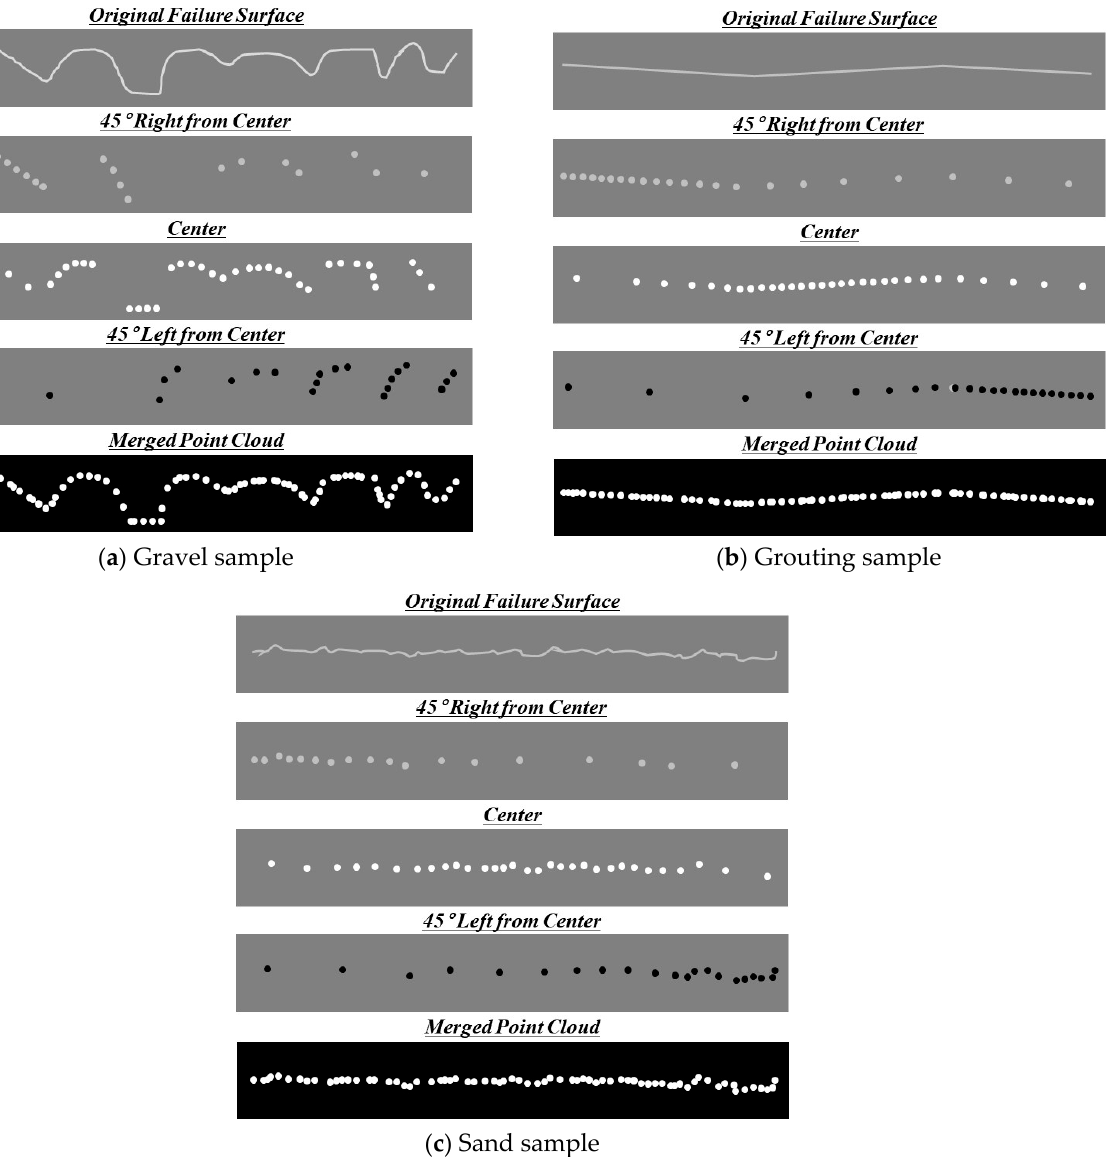
Figure 4. Schematic diagram of point cloud in three samples. Figure 5a shows the raw data of point clouds after the registration process that point clouds are merged into the same coordinate. Unnecessary point clouds in Figure 5a are trimmed for the roughness analysis, which is shown in Figure 5b.